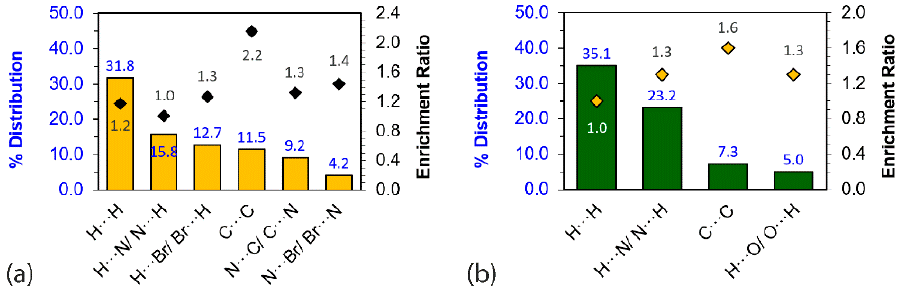
Figure 8. The calculated enrichment ratios (diamonds) greater than unity for selected contacts and their percentage distribution (bars) in ( a ) 1b and ( b ) 1c .